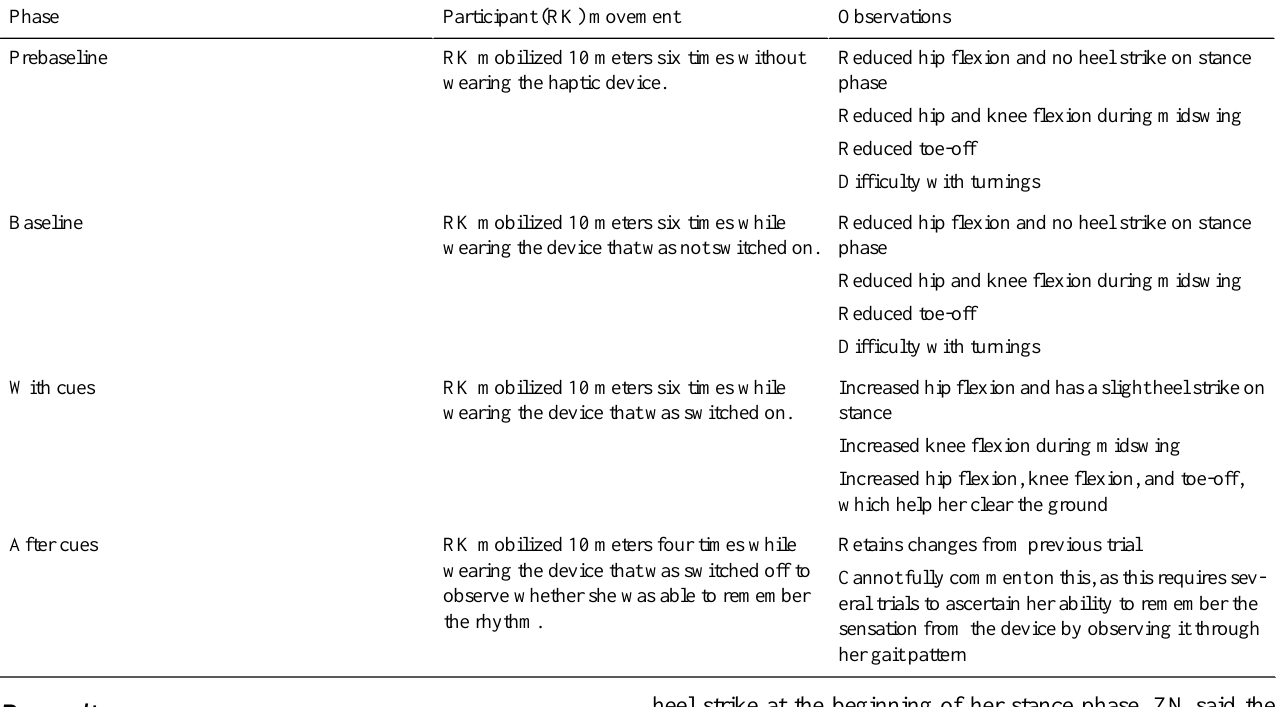
Table 1. Gait-assessment report by physiotherapists.